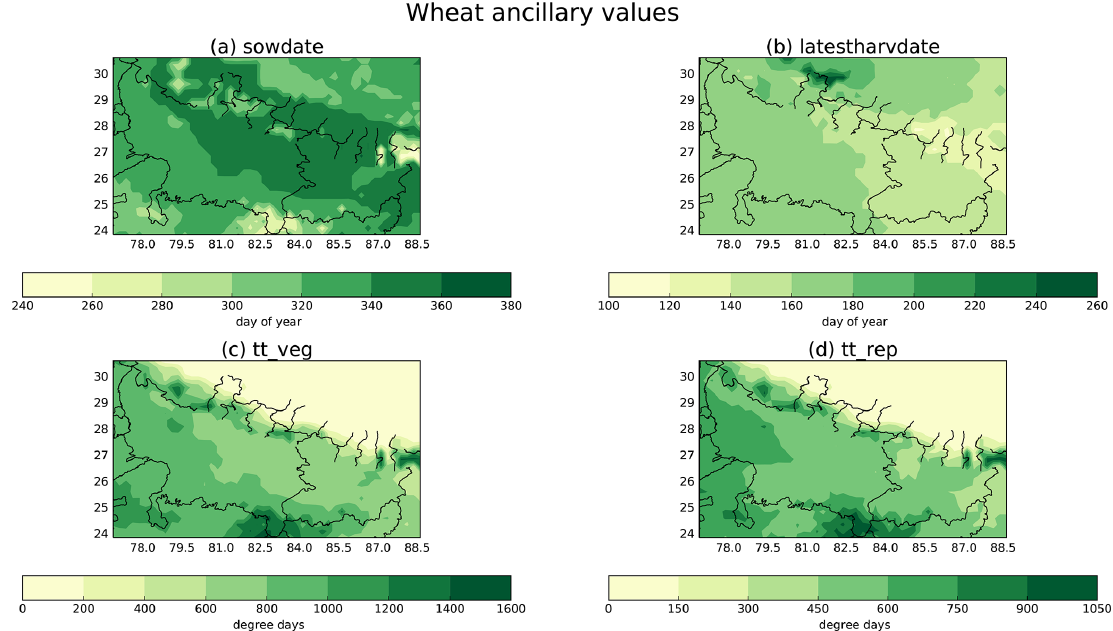
Figure C2. The values used in the regional JULES ancillary for wheat. Sowing date (a) and latest possible harvest date (b) , both in units of day of year. Thermal time for the vegetative stage (c) and thermal time for the reproductive stage (d) , both in units of degree